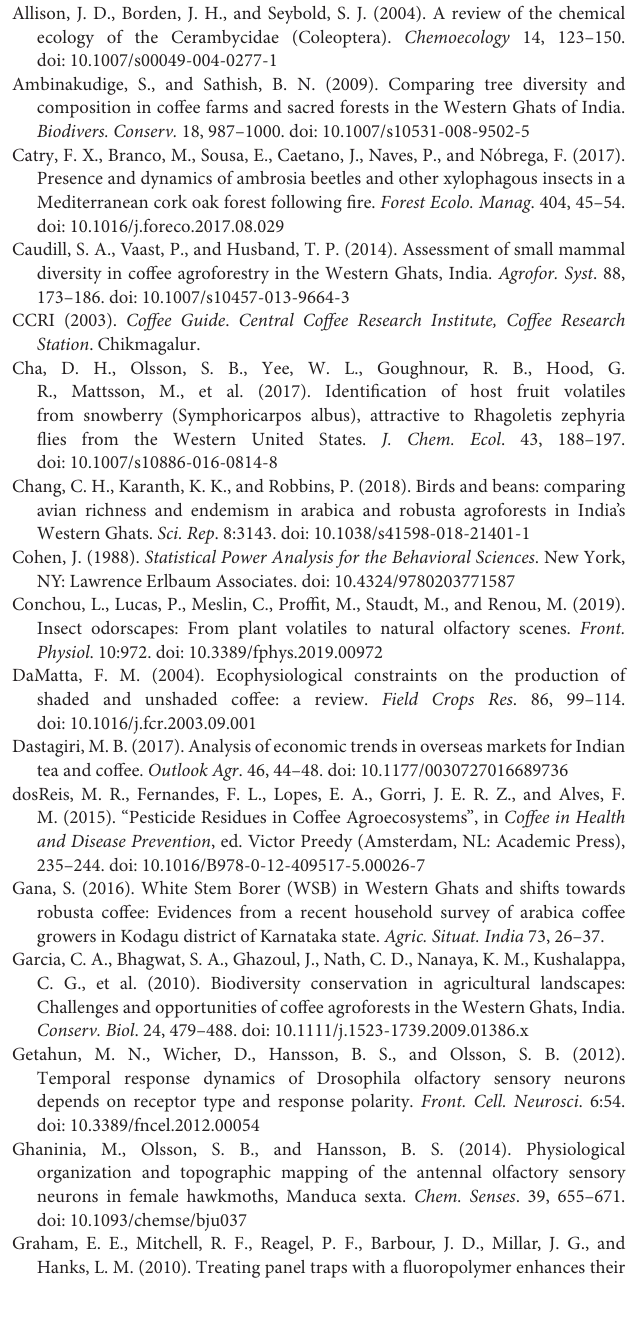
compared with the relative area % of silver oak cut stem volatiles ( n = 6). Supplementary Table 5 | Number of CWSB responses for different compounds during